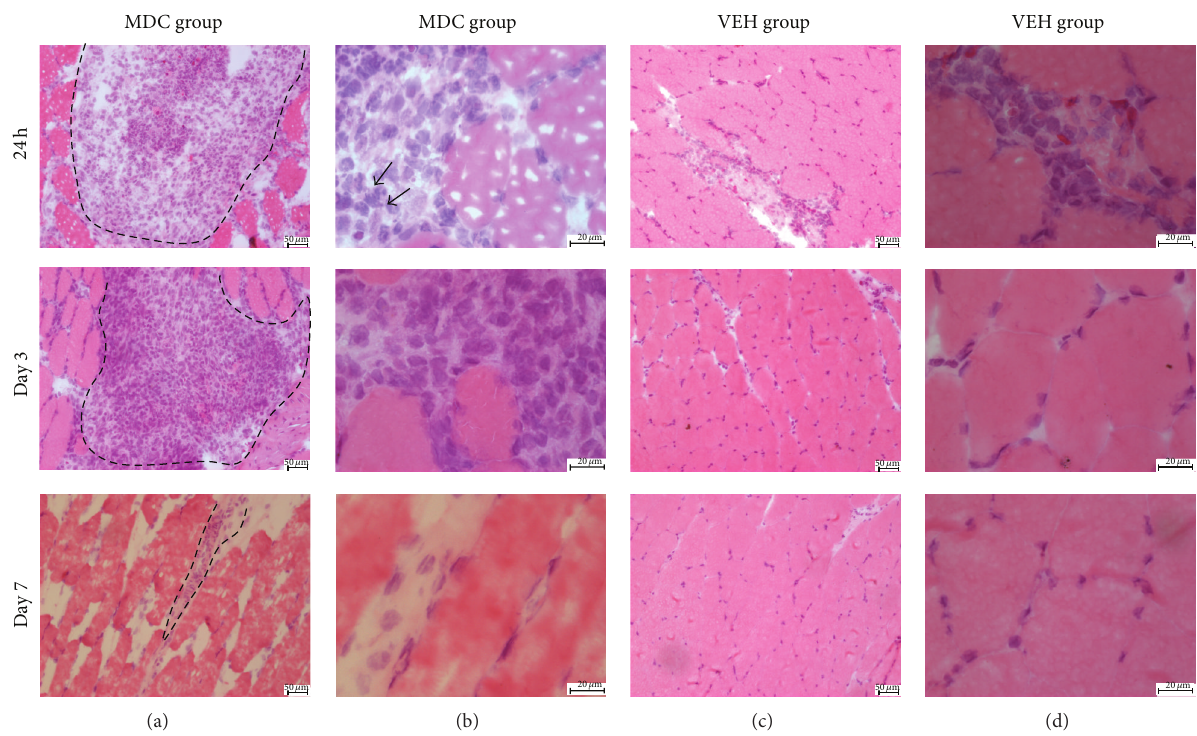
Figure 6: The skeletal muscle stained with hematoxylin and eosin. Images present the area of injection at days 1, 3, and 7 after procedure in subsequent rows. (a and b) Cross sections from transplanted group in two different magnifications. Distinct clusters of injected cells are visible. Dashed lines drawn on images in column A indicate approximate area of clusters located between muscle fibers. At day 1, neutrophils can be recognized within the cluster (arrows). At day 3, identification of neutrophils is not obvious; large mononuclear cells dominate in the cluster. At day 7, inflammatory infiltration is not clearly visible anymore; (c and d) cross sections from group injected with vehicle only in two different magnifications. Some inflammatory cells could be recognized in samples collected at day 1 time point.